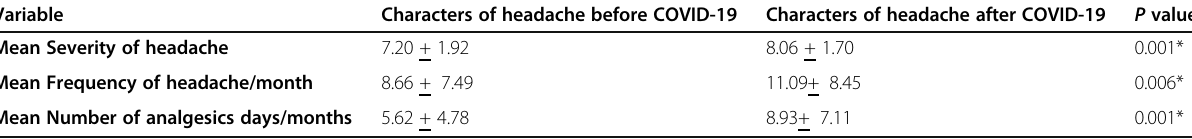
Table 3 Change of headache characters of after COVID-19 Variable Characters of headache before COVID-19 Characters of headache after